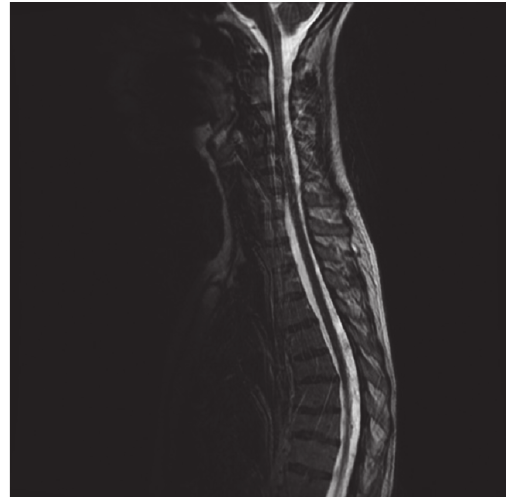
Figure 4: Spine MRI, thoracic region.